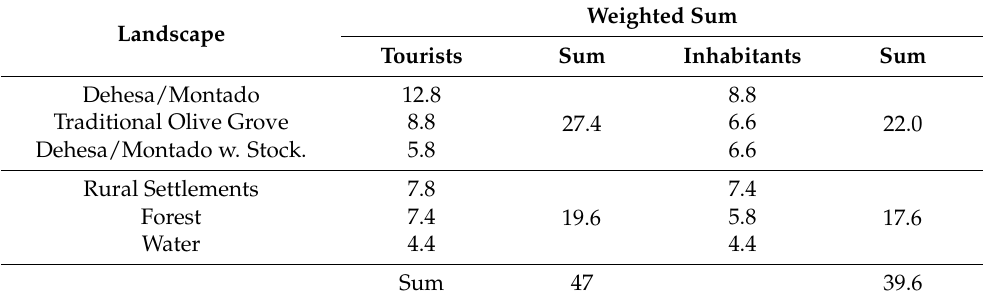
Table 2. Landscape assessment and statistics test to measure differences between the groups.